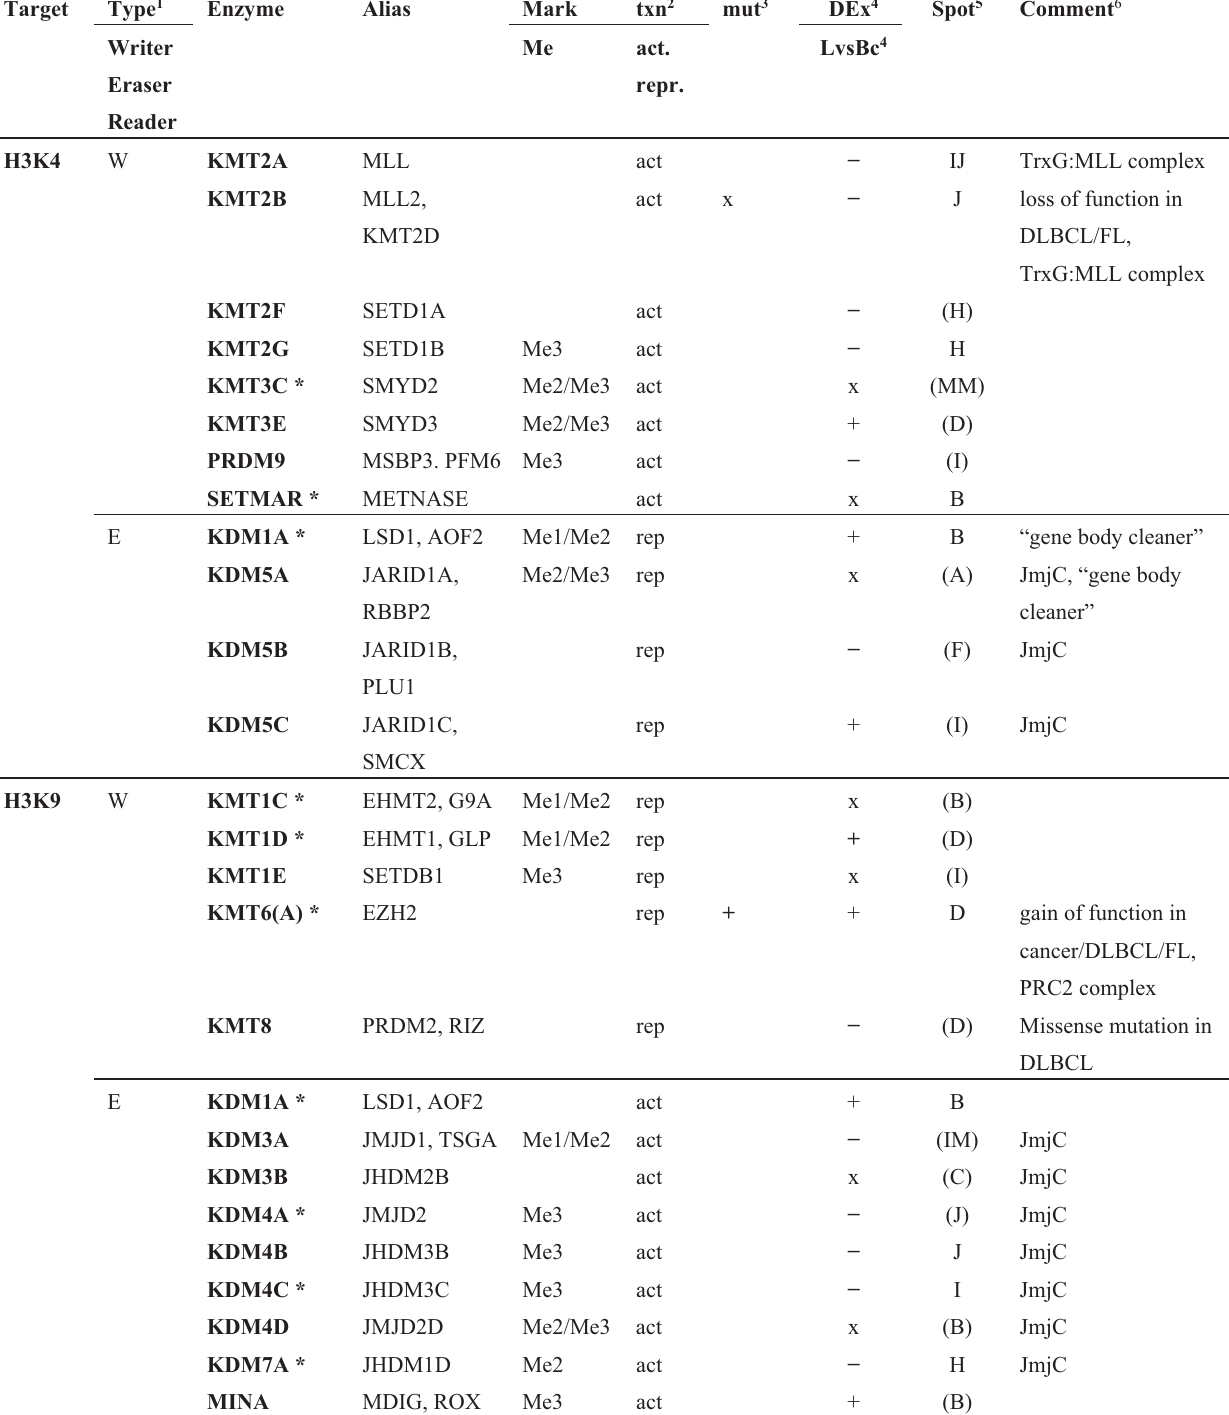
Table 1. Chromatin modifiers with possible relevance for lymphoma: an overview.